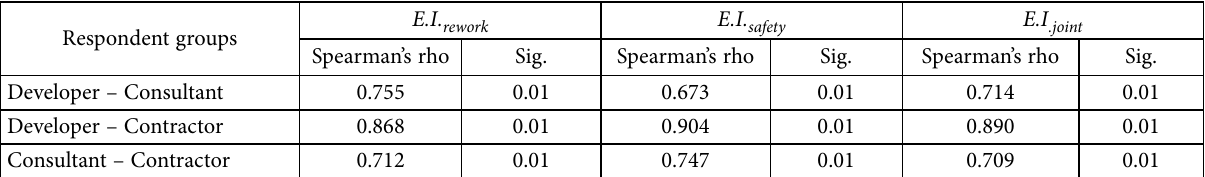
Table 6. Spearman’s rank correlation for the rework and safety management measures Respondent